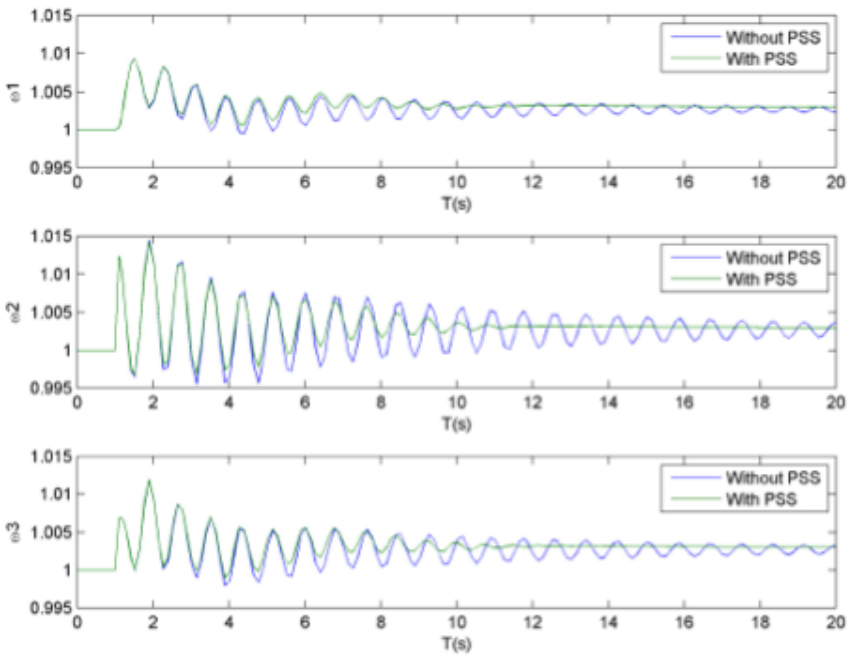
Figure 9. Response of machines 1, 2, and 3 to a three-phase fault at busbar